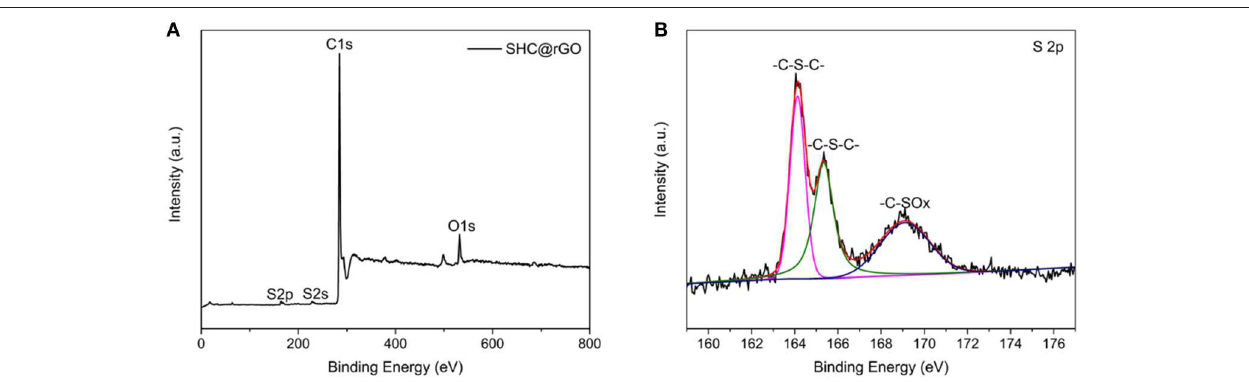
FIGURE 4 | XPS spectra of SHC@rGO composite and survey spectrum (A) and S 2p spectra (B) .